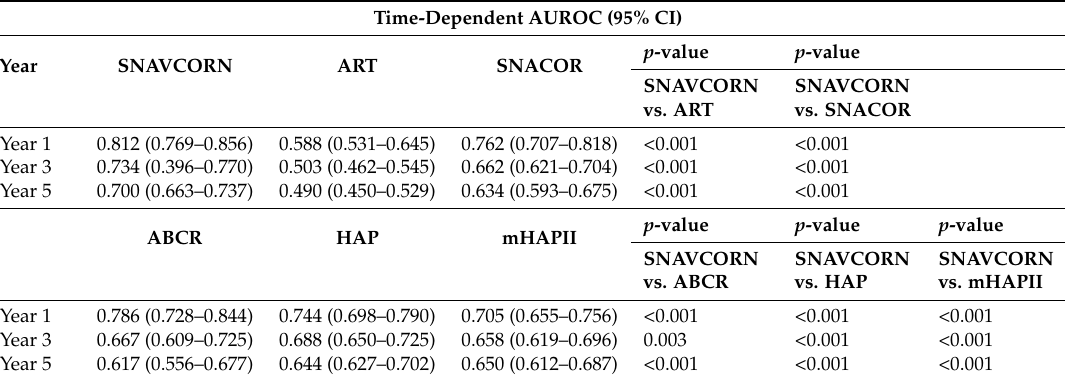
Table 4. Predictive performances of prediction models in derivation set (n =